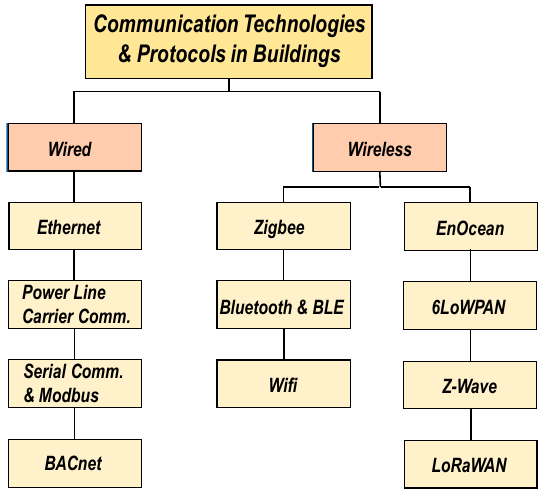
Figure 3. Prominent communication technologies and protocols for building applications. Ethernet, Power Line Carrier Communication (PLCC) and Serial Communications are widely adopted wired technologies whereas Zigbee, Bluetooth and Wifi are the most widely adopted wireless technologies. On the other hand, relatively new technologies and protocols, such as EnOcean, BACnet, 6LoWPAN, Z-Wave and LoRaWAN are still in their infancy in terms of market